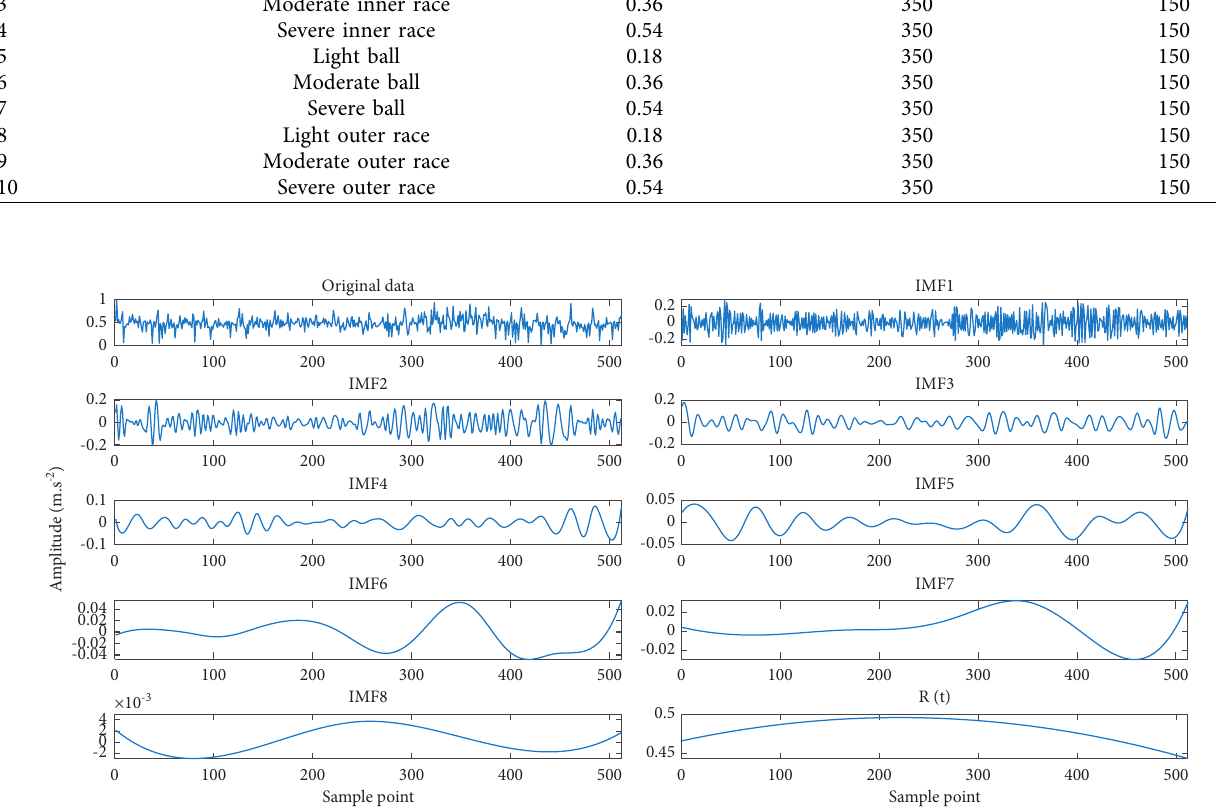
Figure 4: The decomposition of slight fault signal of inner